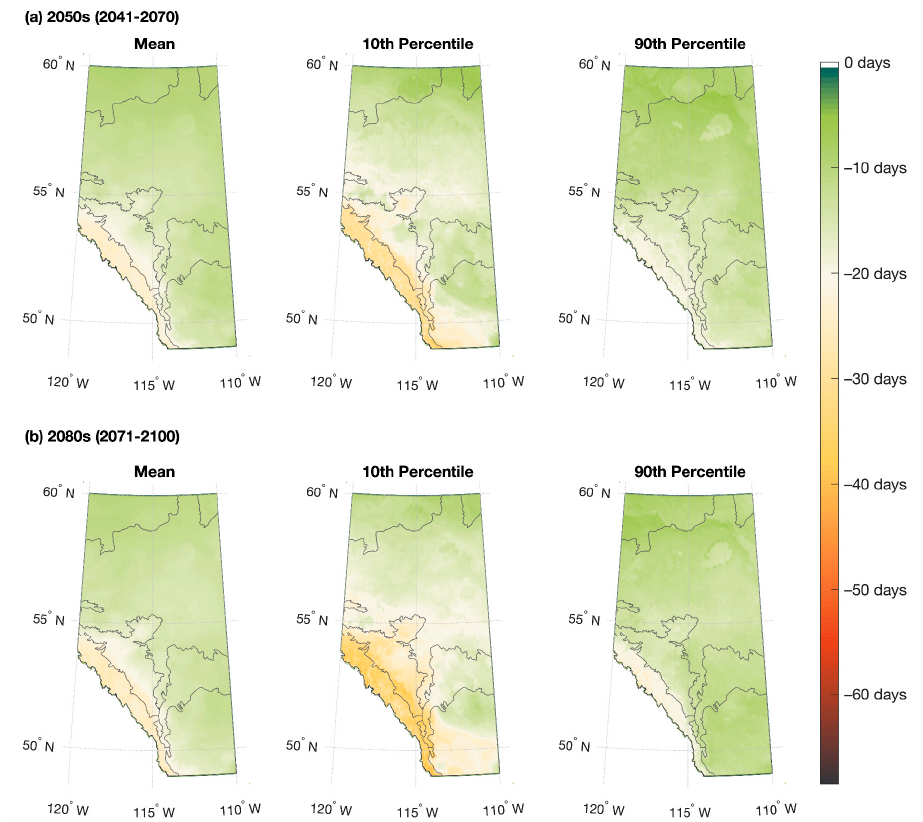
Figure 2. Projected change in spring 0 °C isotherm dates—mean, 10th percentile (earliest), and 90th percentile (latest) between the historic period (1950–2017) and ( a ) 2050s (2041–2070) and ( b ) 2080s (2071–2100) for RCP 4.5.